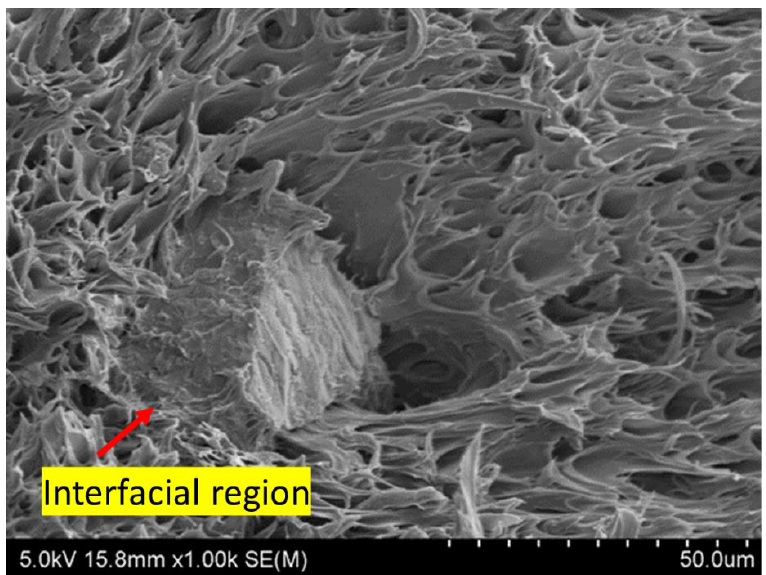
Figure 8. Interfacial region of biochar and PLA/PBAT in PLA/PBAT/BC (79/20/1).